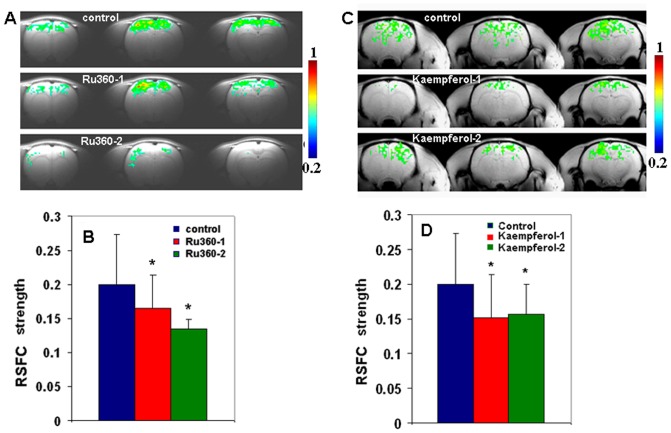
mCU modulation impacted the resting state functional connectivity (RSFC).Inhibition of mCU activity with Ru360 (dose-1 = 120 µg/kg; dose-2 = 240 µg/kg) reduced A. spatial extent of the mean resting state functional connectivity (RSFC) determined using cross correlation of seed voxels from the somatosensory cortex region of interest with all other voxels within the brain in typical animals and reduced B. mean RSFC strength in the cortex over 7 animals within the Ru360 treatment group. Enhancement of mCU activity with Kaempferol (dose-1 = 1 mg/kg; dose-2 = 2 mg/kg) reduced C. spatial extent of the mean resting state functional connectivity (RSFC) in typical animals and reduced D. mean RSFC strength in the cortex over 7 animals within the Kaempferol treatment group. Color scale represents the correlation coefficient (r) values above threshold ≥0.2; uncorrected P<0.0001. Voxels with r≥0.2 were deemed active and corrected with a cluster-size of 10 voxels to control for type-I error. Significantly different compared to control *P<0.01; one-way ANOVA with post-hoc Tukey's HSD test. Error bars represent the group standard deviation.